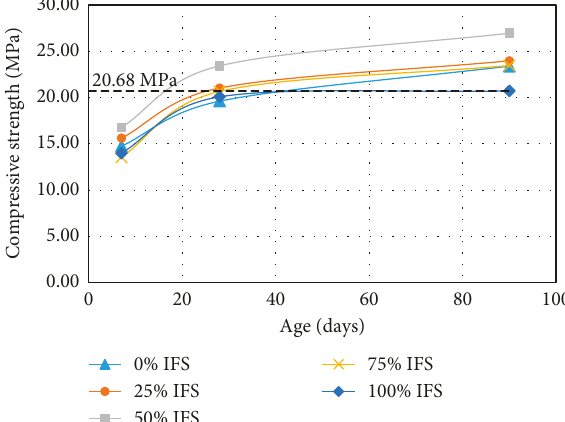
Figure 13: Compressive strength with days for different IFS ratio (target strength: